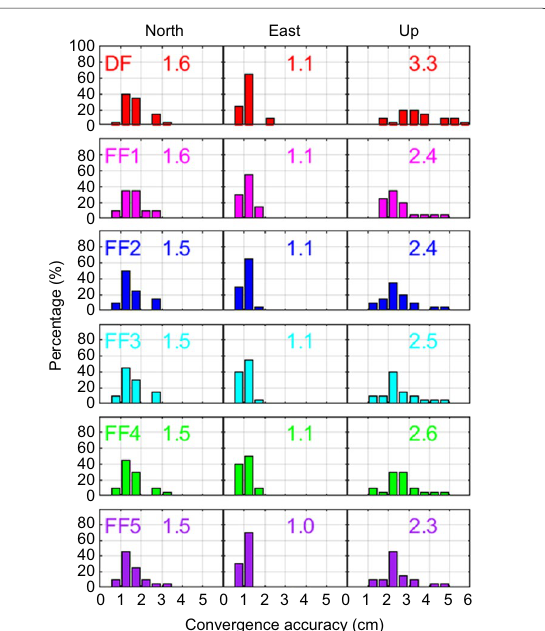
Fig. 5 Distribution of the three-dimensional RMS with different models for the selected 20 stations